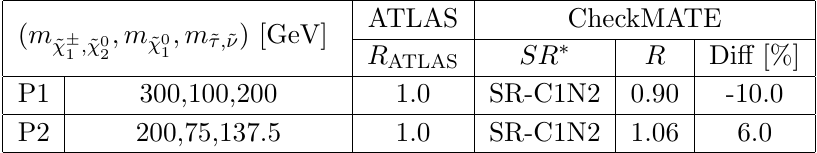
Table 4 . Validation of the ~ (cid:31) (cid:6) ~ (cid:31) (cid:7) and ~ (cid:31) (cid:6) ~ (cid:31) 0 production processes at the 8-TeV LHC by assuming 2 1 1 1 m = m and m ~ (cid:28) = m ~ (cid:23) = ( m + m ) = 2. R ATLAS in the table is the result obtained by ATLAS ~ (cid:31) 0 2 ~ (cid:31) 0 2 ~ (cid:31) (cid:6) 1 ~ (cid:31) (cid:6) 1 collaboration, which is taken from the exclusion line of (cid:12)gure 7a in [125]. SR (cid:3) and R have same meanings as those in table 3, and Di(cid:11) (cid:17) ( R (cid:0) R ATLAS ) =R ATLAS , which parameterizes the deviation of our calculation from its corresponding ATLAS result.